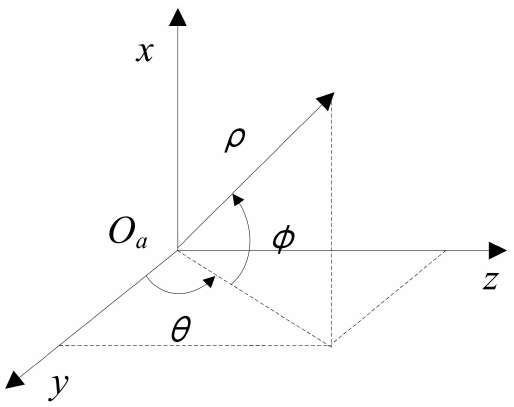
Figure A2. Measurement angle and relative distance of the asteroid in the asteroid Hill rotating reference